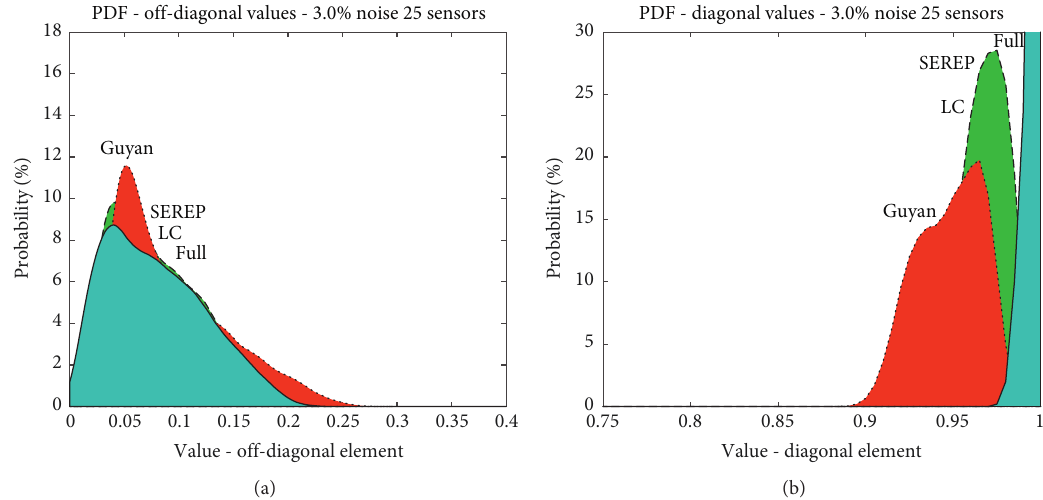
Figure 7: (a) PDFs of the maximal off-diagonal elements. (b) PDFs of the minimal diagonal elements. Both with 3 pct. Noise on the modes and 25